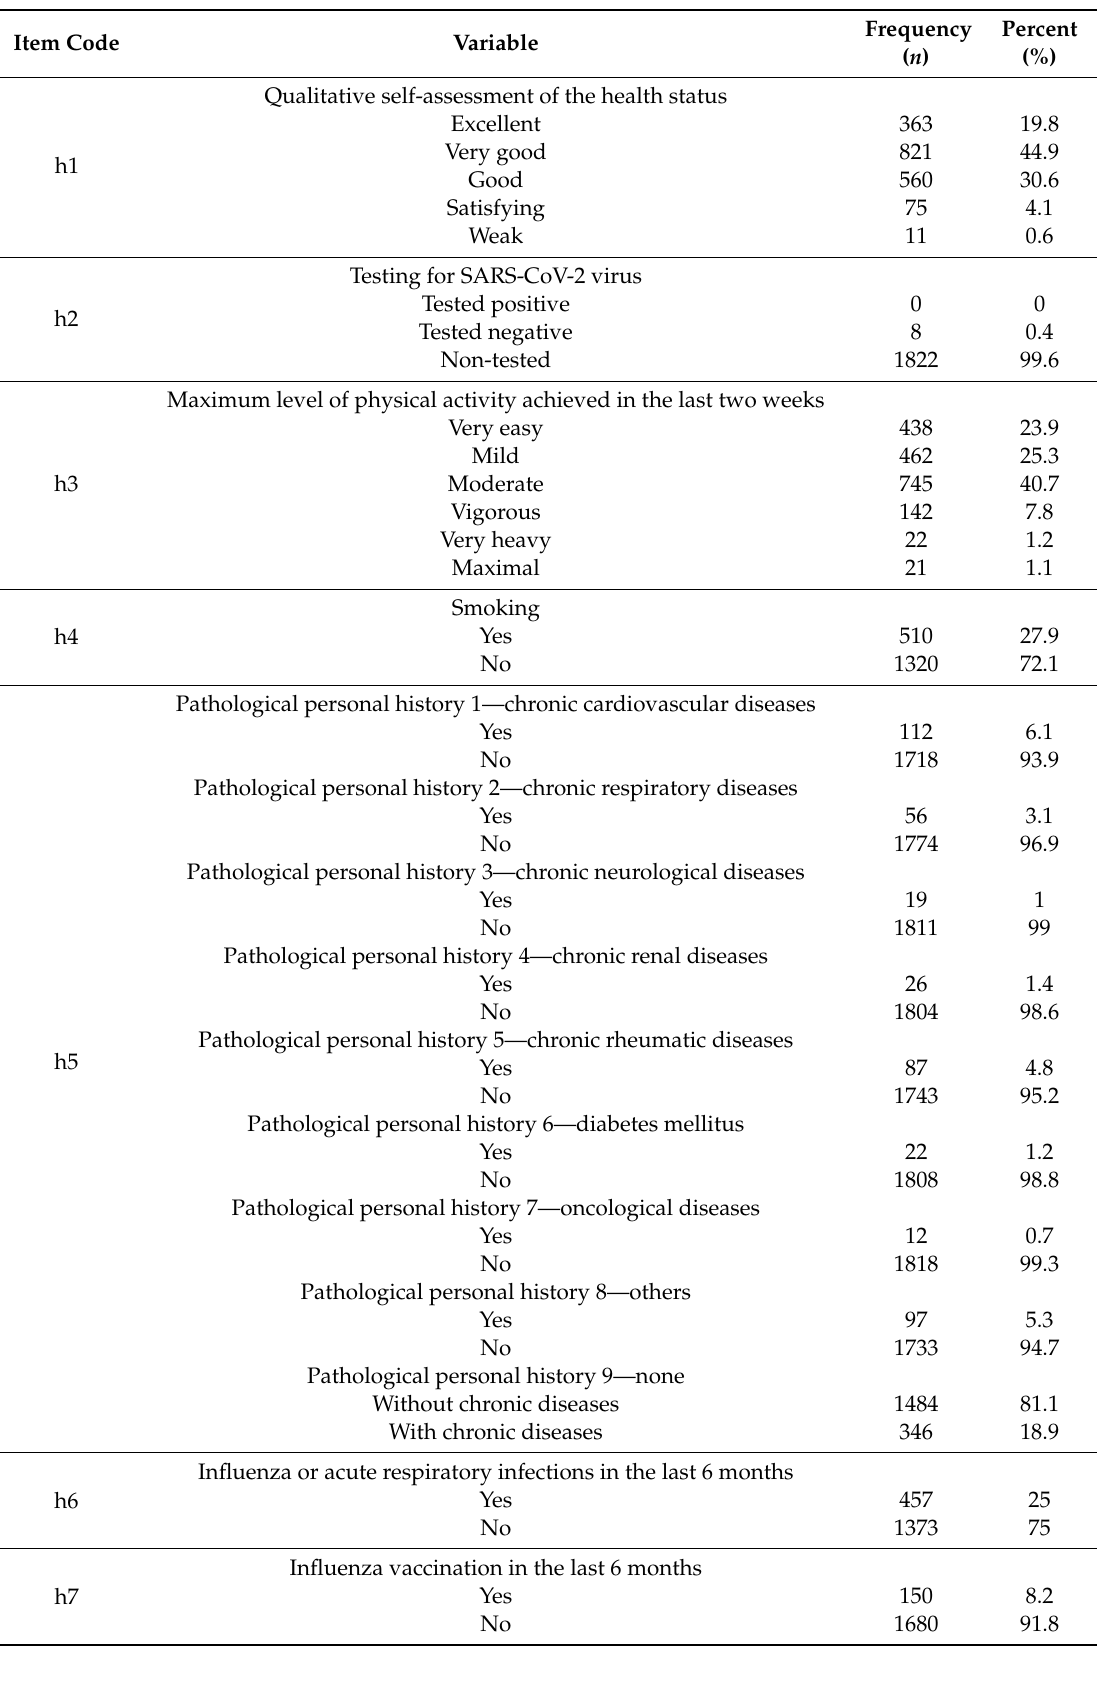
Table 2. Summary of the health status characteristics of study participants (N =